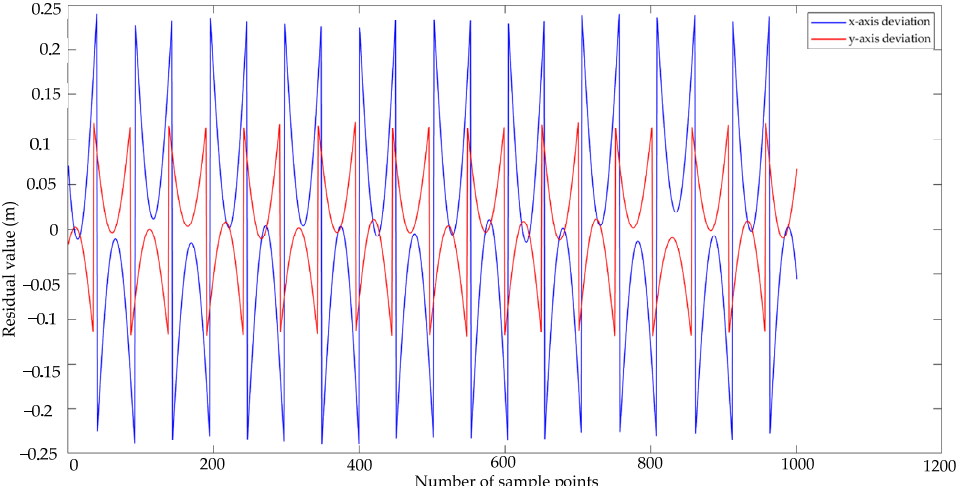
Figure 18. x -axis and y -axis deviation graph curves.